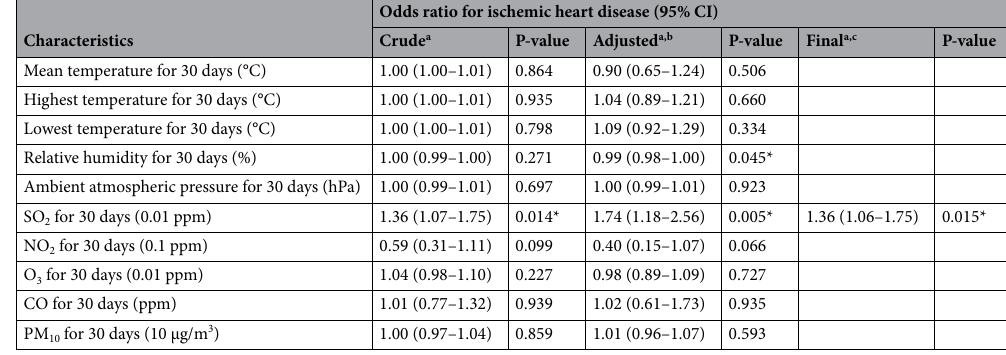
Table 2. Crude and adjusted odd ratios (95% confidence interval) of the meteorological and pollution matter (mean of 30 days before the index date) for ischemic heart disease. *Conditional logistic regression model, Significance at P < 0.05. a Stratified model for age, sex, income, and region of residence. b Adjusted model was adjusted for obesity, smoking status (current smoker compared to nonsmoker or past smoker), frequency of alcohol consumption (≥ 1 time a week compared to < 1 time a week), CCI score, mean temperature, highest temperature, lowest temperature, relative humidity, atmospheric pressure, SO 2 , NO 2 , O 3 , CO, and PM 10 . c Final model was adjusted for obesity, smoking status (current smoker compared to nonsmoker or past smoker), frequency of alcohol consumption (≥ 1 time a week compared to < 1 time a week), CCI score, relative humidity, SO 2 , NO 2 , O 3 , CO, and PM 10 using the backward selection method.